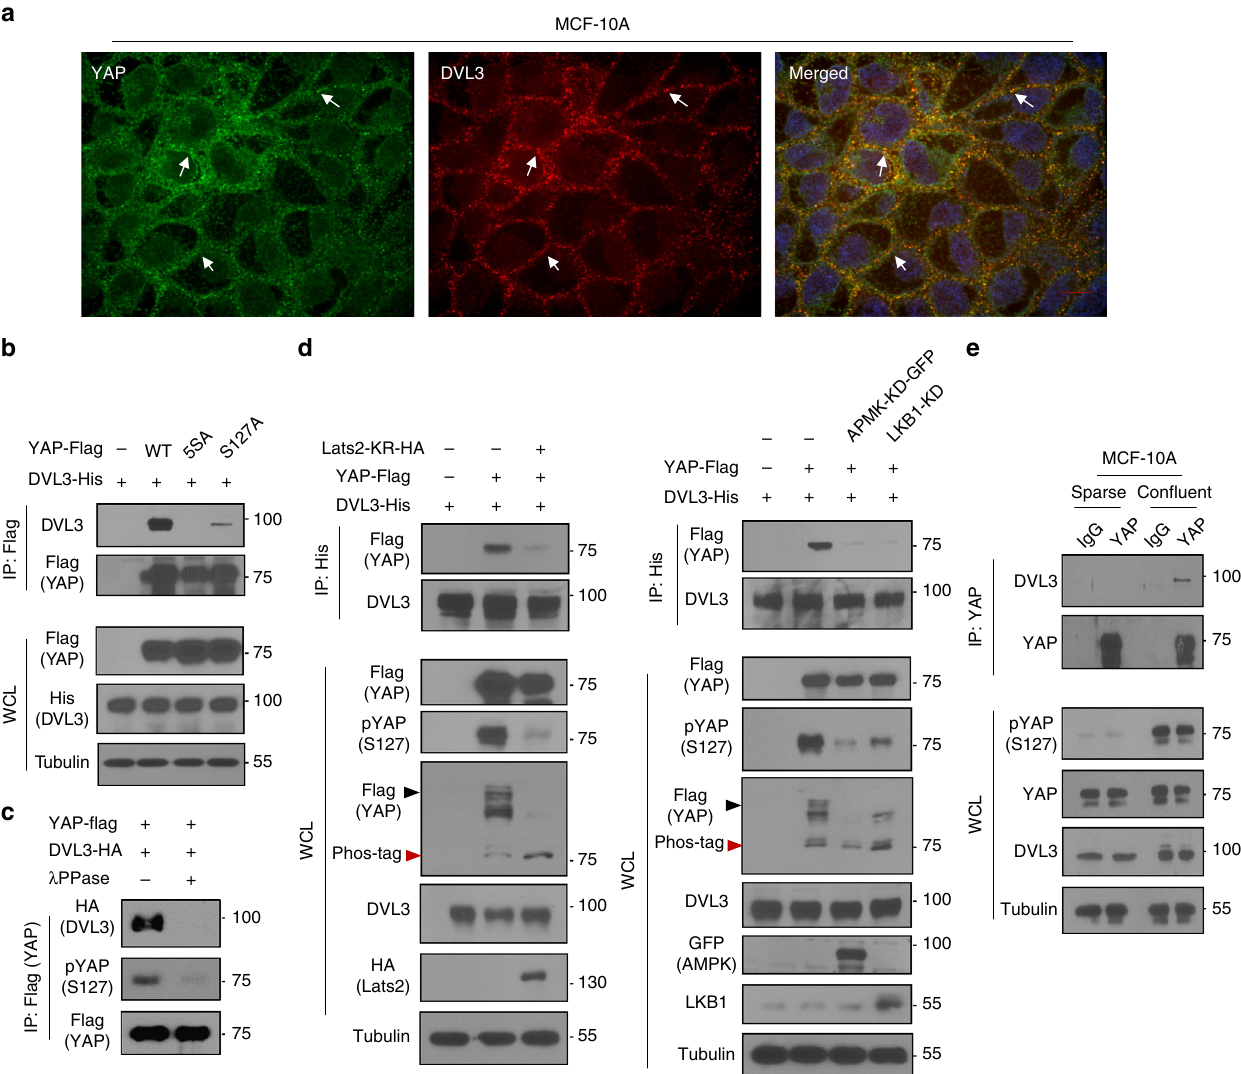
Fig. 1 DVL interacts with phosphorylated YAP. a Confocal images of endogenous YAP (green) and DVL3 (red) in MCF-10A cells. Arrows indicate co- localized foci. Nuclear staining with TOPRO3 (blue) is shown in merged image. Scale bar, 10 μ m. b DVL interacts with YAP in a phosphorylation-dependent manner. In all, 293 cells were transfected with His-tagged DVL3 and vector control ( − ) or fl ag-tagged YAP or mutants (5SA, S127A). Interactions between DVL and YAP were determined following immunoprecipitation (IP) with anti- fl ag antibody and immunoblotting with anti-HA. Whole-cell lysate (WCL) serves as input abundance for IP. c Lambda protein phosphatase ( λ PPase) treatment to immunoprecipitated YAP abolishes DVL binding. The 293 cells were transfected with fl ag-tagged YAP and immunoprecipitated anti- fl ag beads were treated with λ PPase ( + ). The agarose beads were then subjected to binding to HA-tagged DVL. d Kinase-dead dominant negative Lats2 (Lats2-KR) or AMPK (AMPK-KD) or LKB1 (LKB1-KD) abolishes YAP and DVL interaction. Flag-tagged YAP and His-tagged DVL3 expression vectors were co-transfected with the dominant negative expression vectors as indicated in 293 cells. Interactions between DVL3 and YAP were determined as described above and phosphorylation status of YAP was determined by pS127-YAP antibody and mobility shift on a phos-tag gel. Black and red arrowheads correspond to the fully phosphorylated and active YAP on a phos-tag gel, respectively. e The MCF-10A cells were cultured under sparse and con fl uent states, and the whole-cell lysates (WCL) were subjected for